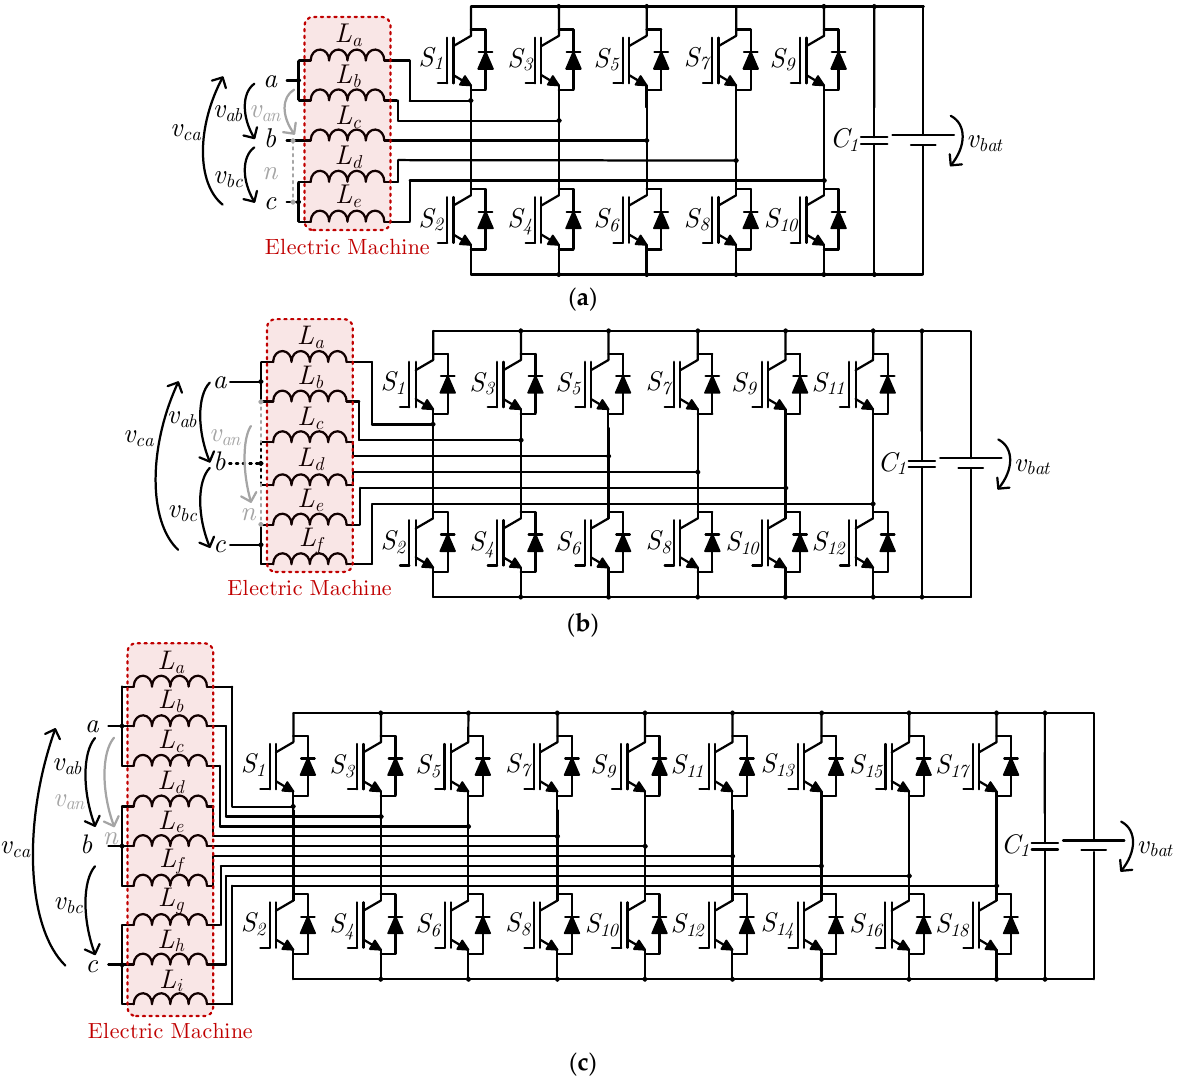
Figure 19. EV IBCs proposed by I. Subotic et al. and V. Katic et al. in 2016 [38–40] based on electric machines with phase counts equal to: ( a ) five; ( b ) six; ( c ) nine.